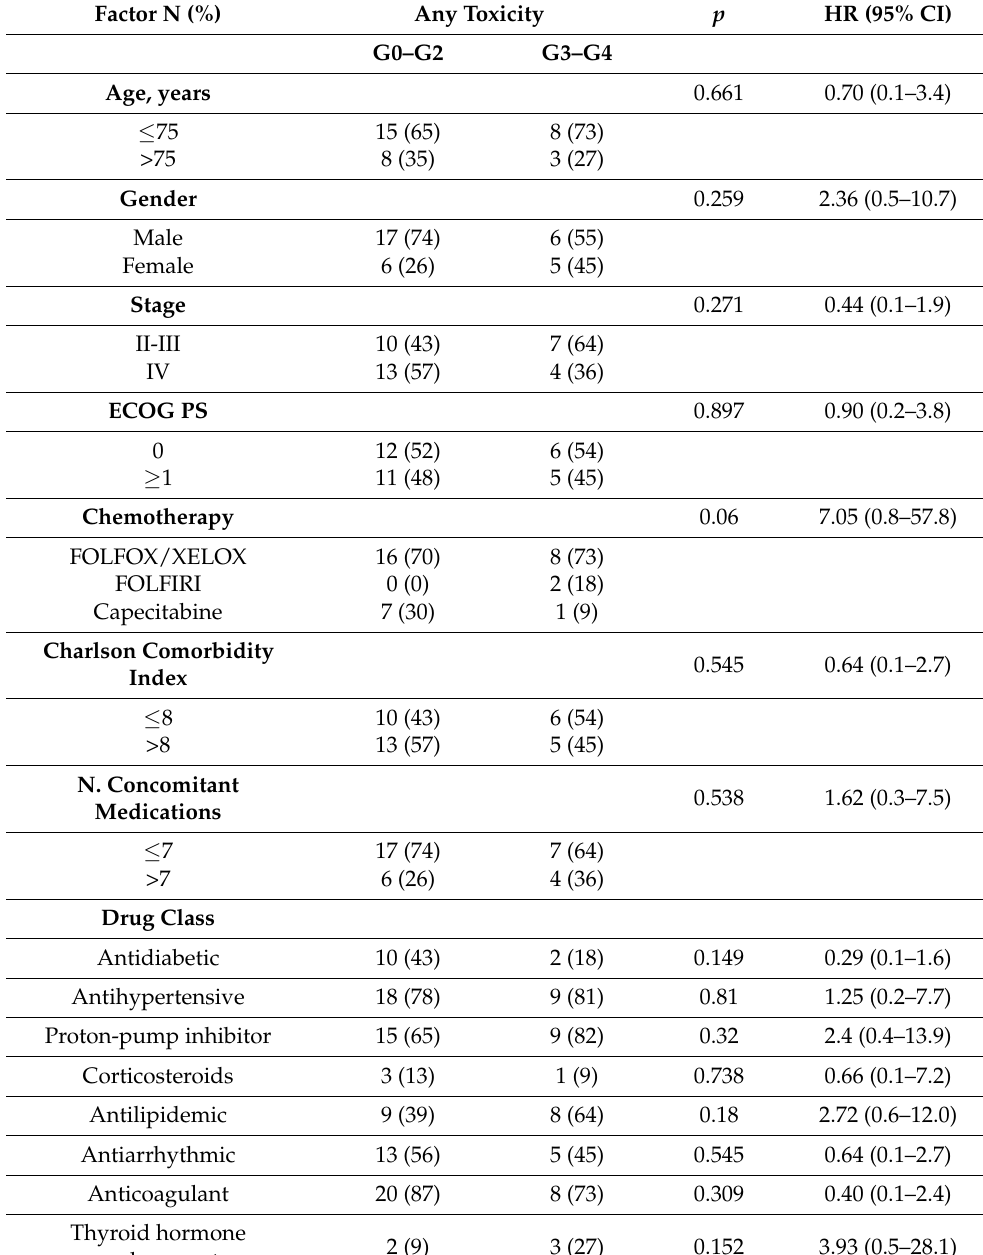
Table 2. Correlation between any toxicity and clinical characteristics of the study